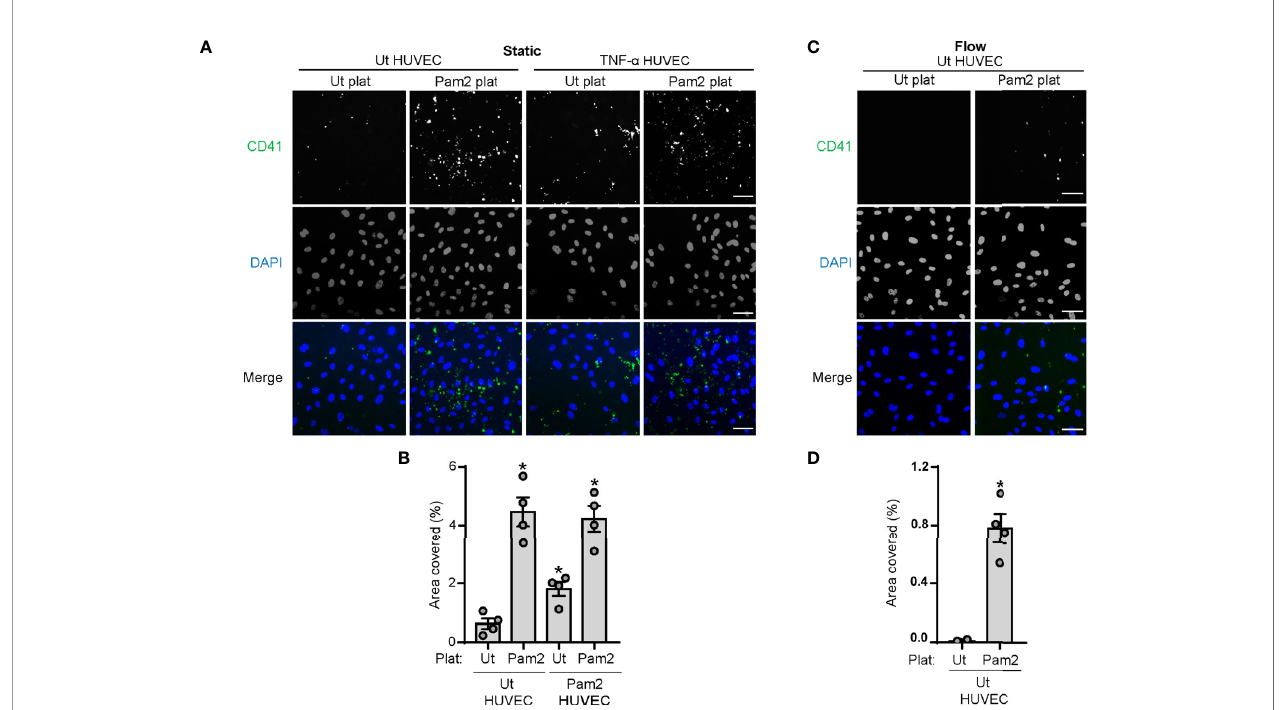
FIGURE 6 | Stimulation with Pam2CSK4 increases platelet adhesion to HUVECs under static and fl ow conditions. HUVECs were seeded to con fl uence into Ibidi µ- Slide VI 0.1, serum starved for 2 h and stimulated with TNF- a at 1 ng/ml for 4 h when indicated. (A – D) Platelets (2x10 8 /ml) were stimulated with Pam2CSK4 (10µg/ ml) and stained with a a -CD41 antibody (1:10) for 10 min at 37°C before co-culture with HUVECs. (A, B) For static assays, platelets (50 µl) where diluted 1:1 in SFM and incubated with HUVEC for 10 min at 37°C; n=4 experiments. (C, D) For fl ow adhesion experiments, platelets were fl owed for 5 min at a fl ow rate of 18.69 µl/min; n=4 experiments. Cells were imaged using an inverted microscope with a 20X objective (Zeiss Axiovert 200M, Carl Zeiss). 5 random images were taken per fi eld and data are presented as percentage of area covered by platelet CD41 staining. Scale bar indicates 50 µm. * indicates statistical signi fi cance (p<0.05) compared to untreated (Ut). Error bars indicate standard error of the mean